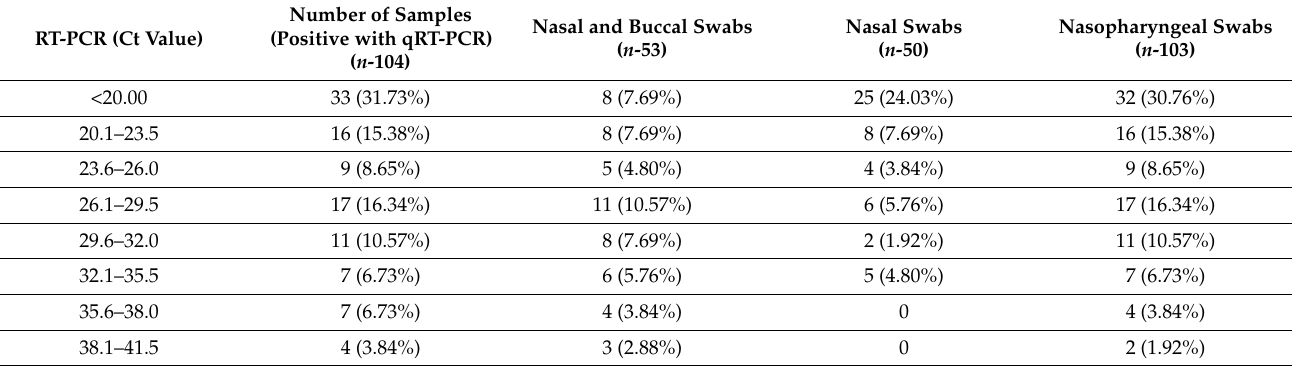
Table 5. Comparison of different tested samples with qRT-PCR Ct